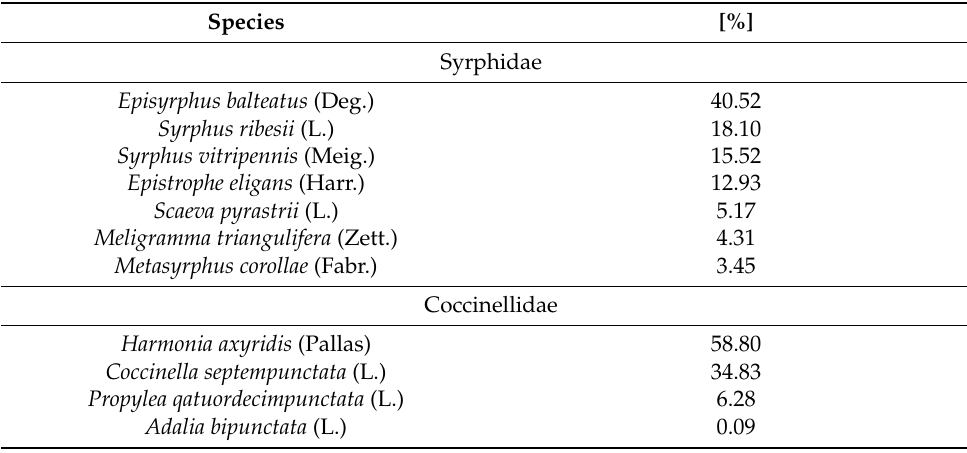
Table 5. Species composition of Syrphidae and